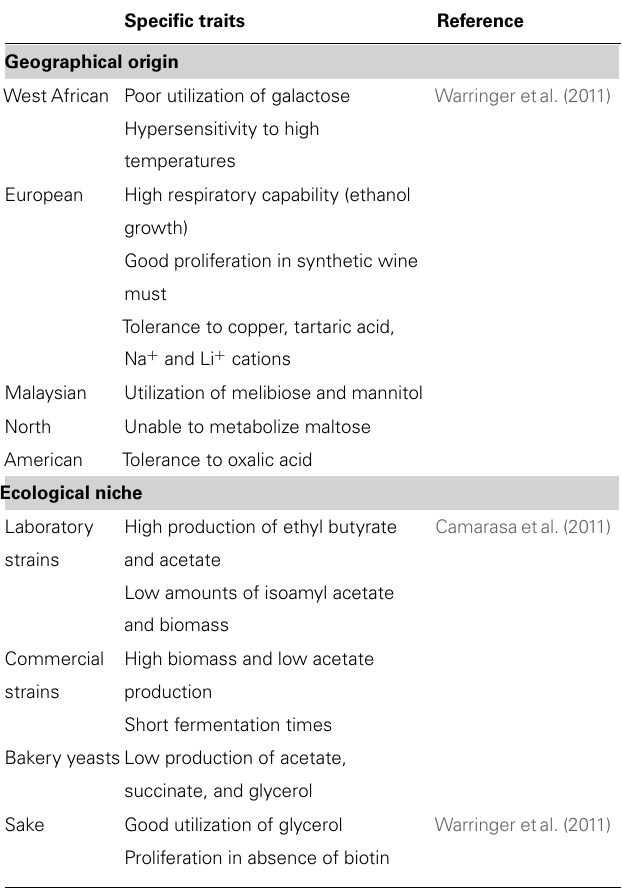
Table 2 | Some traits of Saccharomyces cerevisiae strains from different